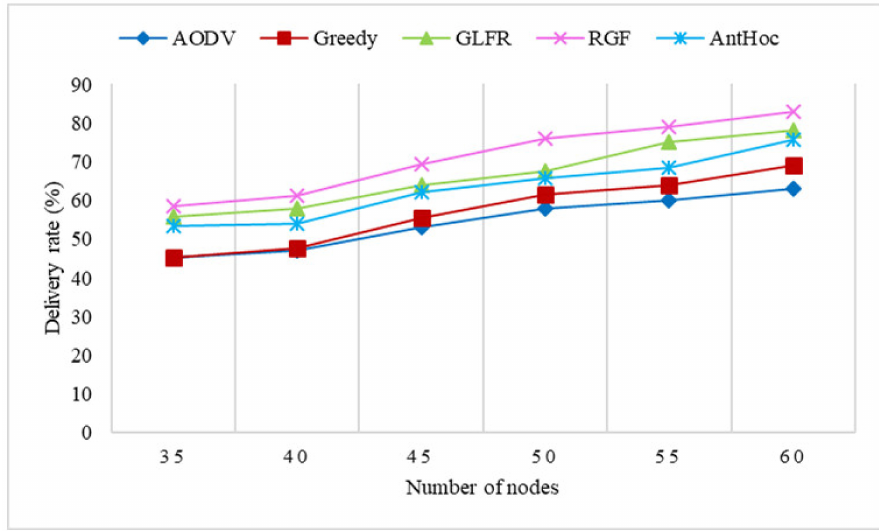
Figure 17. The effect of the number of nodes on the delivery rate.